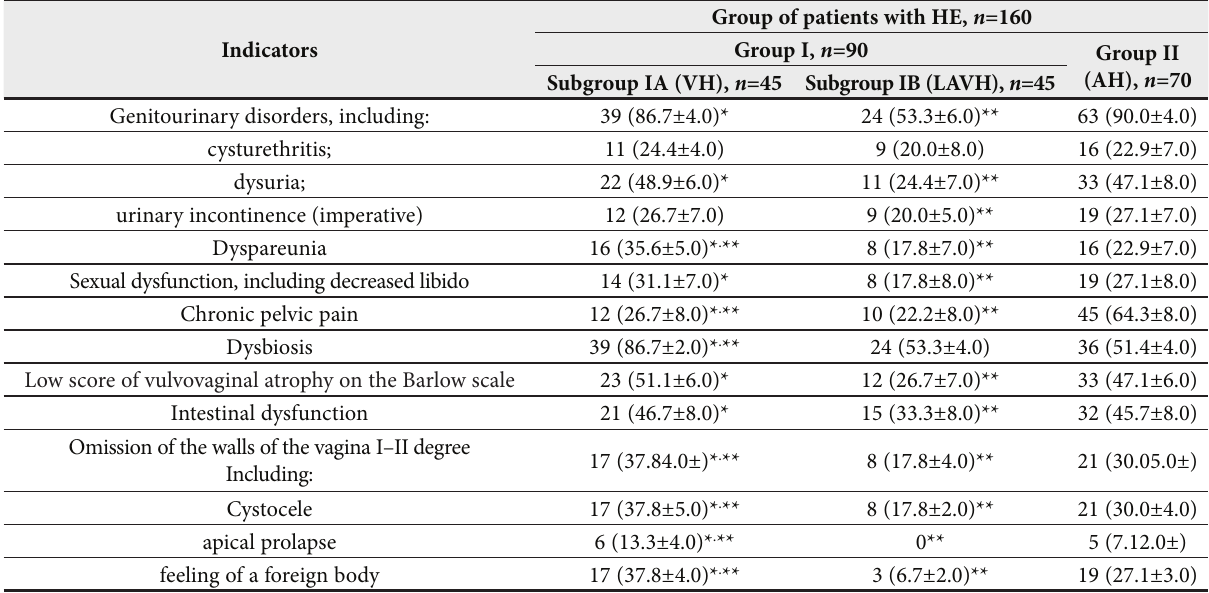
Group of patients with HE, n =160 Group І, n =90 Group ІІ (AH), n =70Subgroup ІА (VH), n =45 Subgroup ІВ (LAVH), n =45